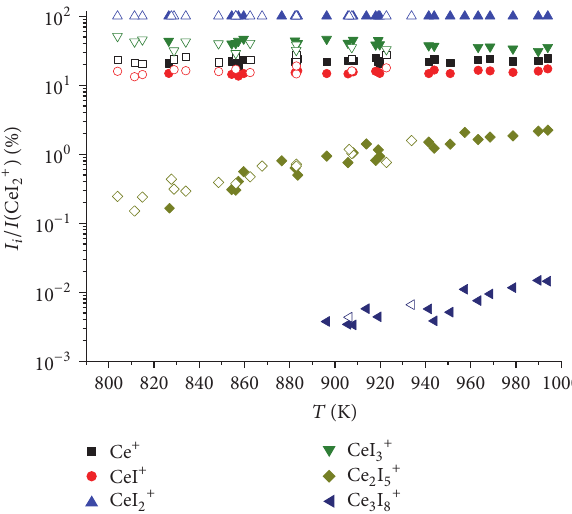
Figure 2: Temperature dependence of the mass spectra of CeI 3 . Heating and cooling runs are marked by solid and open symbols,